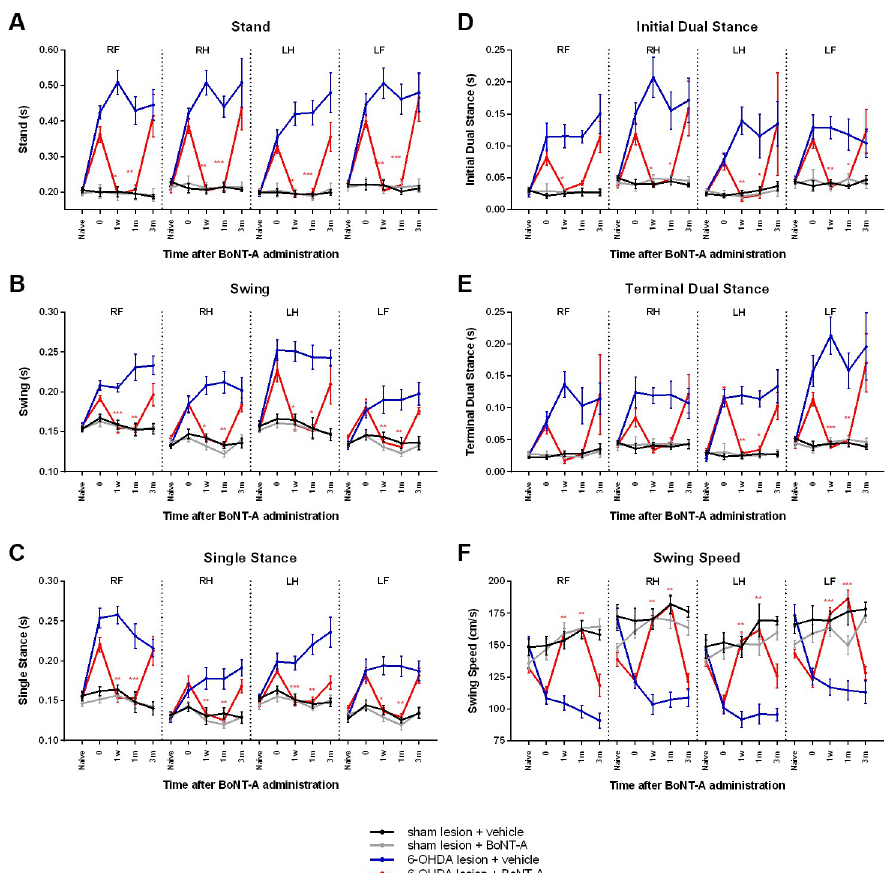
Fig 1. Dynamic gait parameters affected by BoNT-A. Changes in dynamic gait parameters measured by the CatWalk apparatus for each experimental group (n = 8 per group). Paws were measured individually (RF: right front, RH: right hind, LF: left front, and LH: left hind). Experimental timepoints are reflected on the x-axis: na ï ve rats tested prior to any surgeries, 6-OHDA (or sham infused) animals tested at timepoint 0, and BoNT-A (or sham vehicle) animals tested at 1 week, 1 month or 3 months following BoNT-A surgery. All results are presented as mean ± SEM. Asterisks indicate significant changes compared to timepoint 0 according to repeated measures one-way ANOVA and post-hoc Tukey test. � p < 0.5 �� p < 0.01 ��� p <